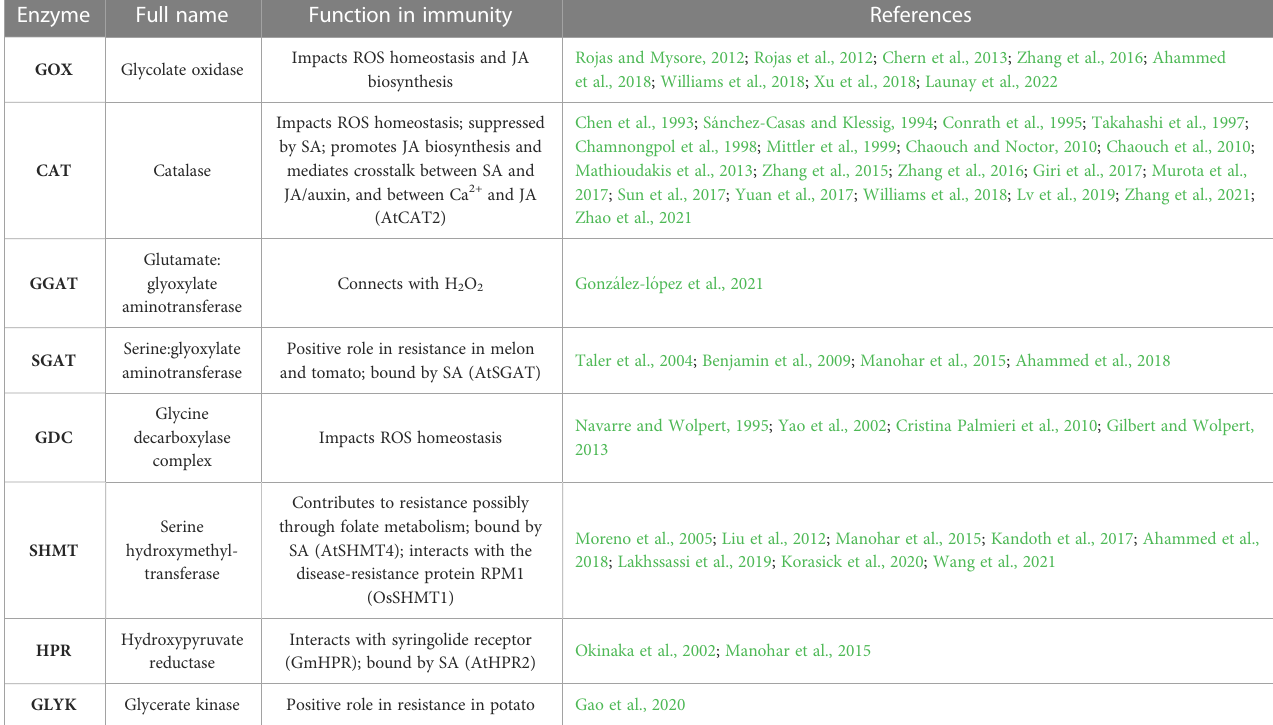
TABLE 1 Photorespiratory enzymes that participate in defense response.